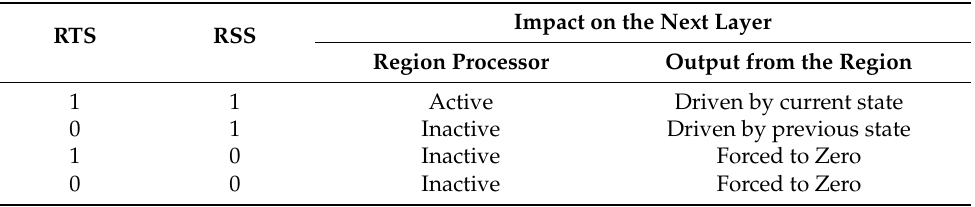
Table 1. Impact of temporal and spatial saliency score for next layer processors.